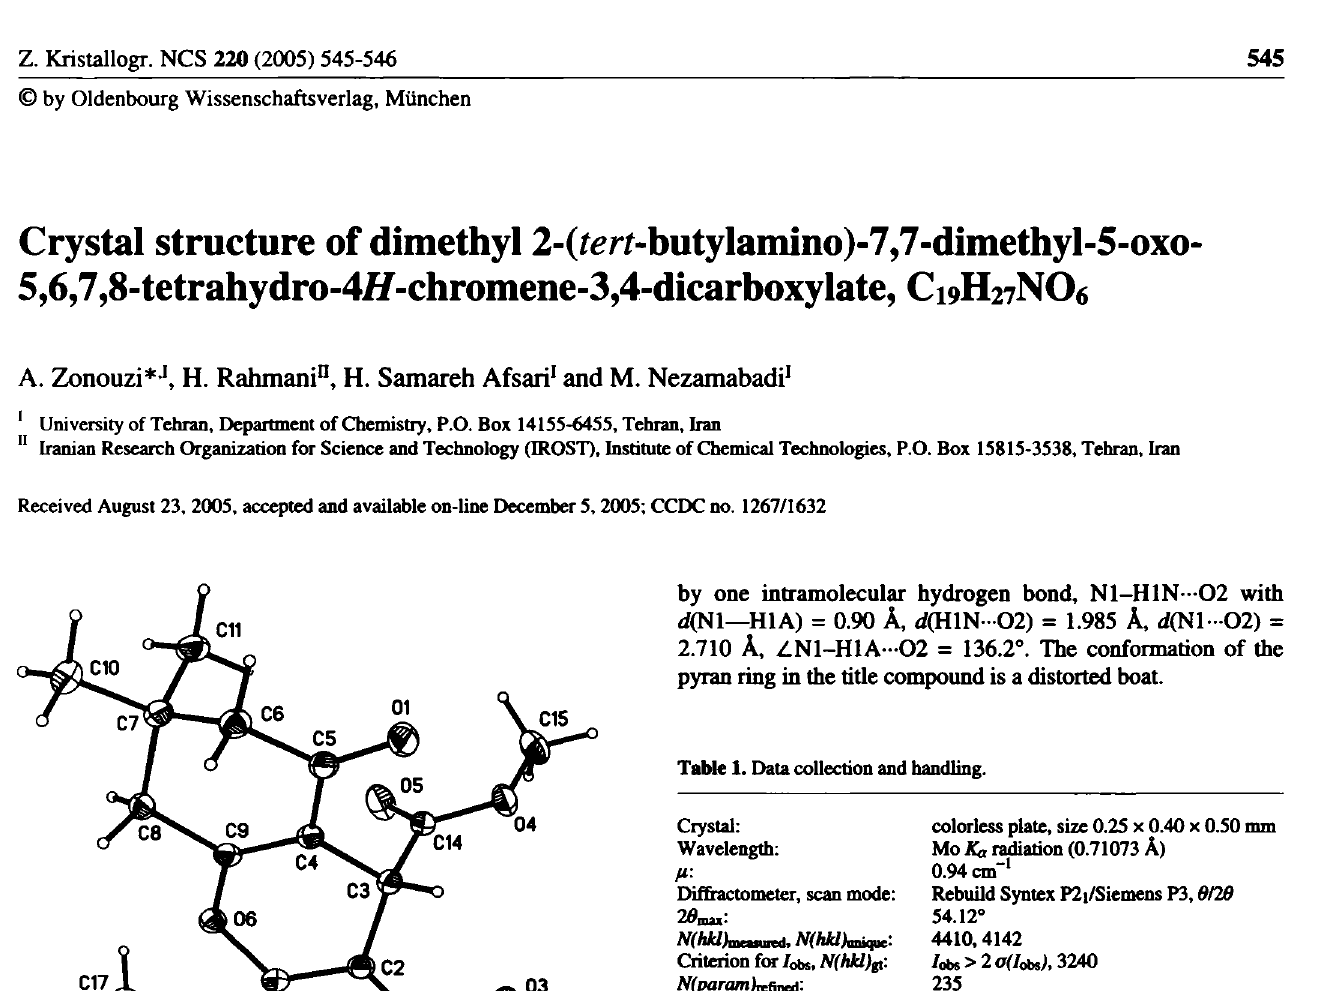
Table 2. Atomic coordinates and displacement parameters (in Ä 2